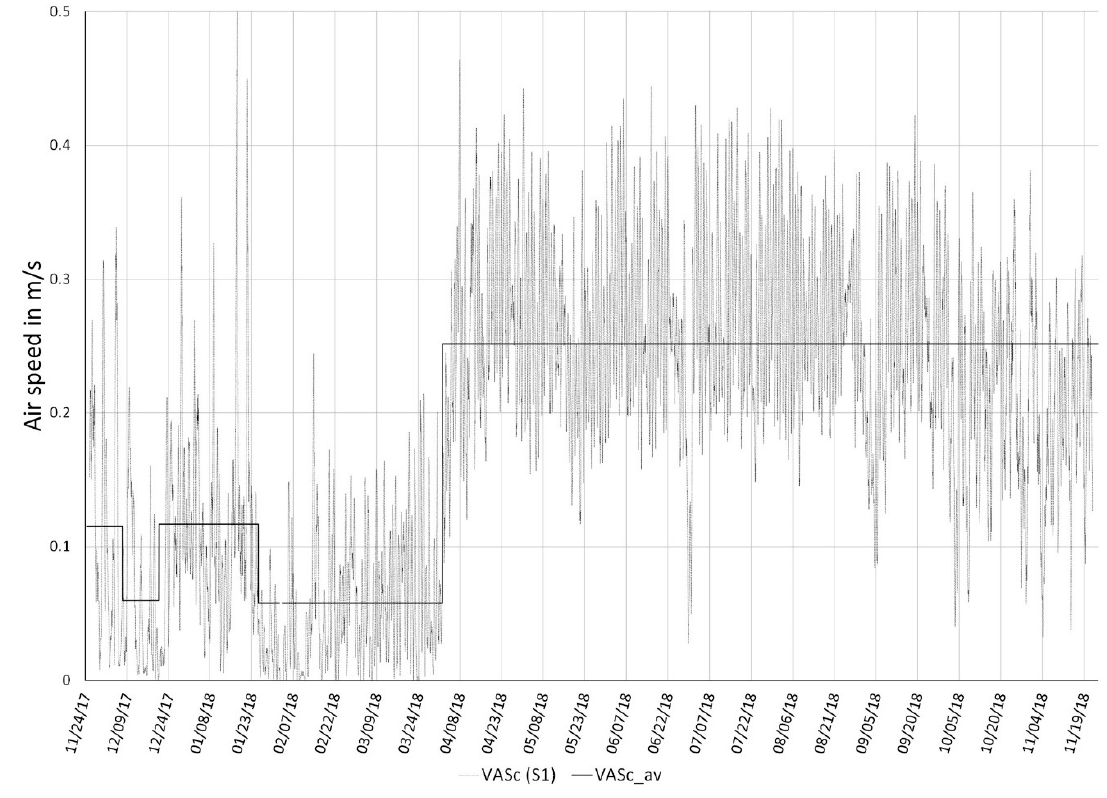
Figure 8. Air speed in the ventilation layer over the total measuring time.